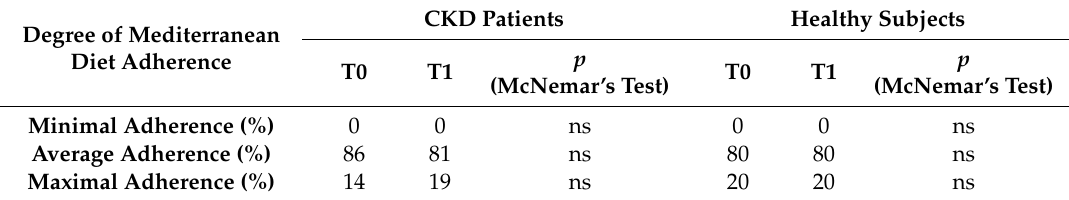
Table 12. PREDIMED questionnaire.